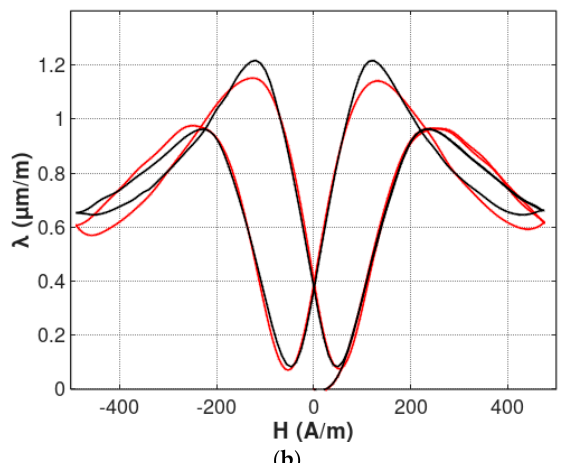
Figure 7. Results of modeling the magnetostrictive hysteresis loops of Mn 0.70 Zn 0.24 Fe 2.06 O 4 ferrite for power applications: ( a ) λ (B) hysteresis loop; ( b ) λ (H) hysteresis loop. Experimental results—red line; results of modeling—black line.